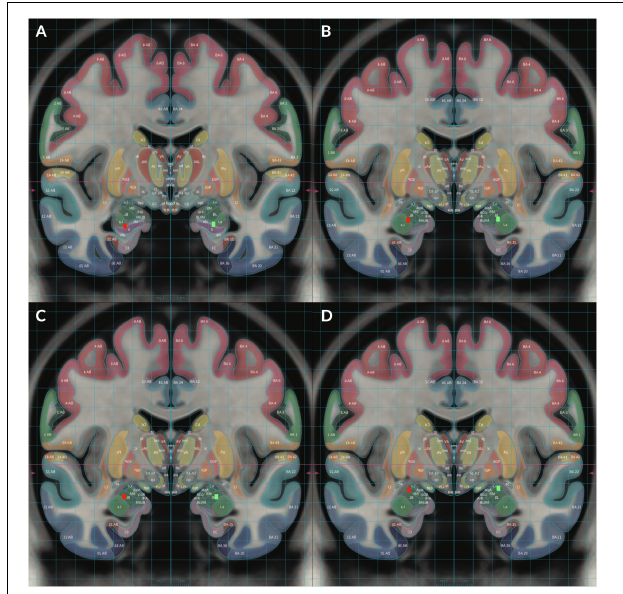
FIGURE 2 | To demonstrate locations of each electrode, Subject 2’s MRI brain imaging studies were registered to the MNI space (MNI152 NLIN2009a) and then overlaid on the structural atlas of Mai (Horn and Kühn, 2015; Mai and Majtanik, 2017) to allow delineation of cerebral cortices and subcortical structures with color coded representations of cortical and subcortical parcelation according to the Mai atlas. The red rectangular markers represent right sided DBS electrode contacts 8–11 while the green rectangular markers represent left sided contacts 0–3. Contact 0 was placed in the left HC and contact 8 was placed in the right HC (A) . Contact 1 was placed in the left ventral BLA and contact 9 was placed in the right ventral BLA (B) . Contact 2 was placed in the left dorsal BLA and contact 10 was placed in the right dorsal BLA (C) . Contact 3 was placed in the left CeA and contact 11 was placed in the right CeA (D)